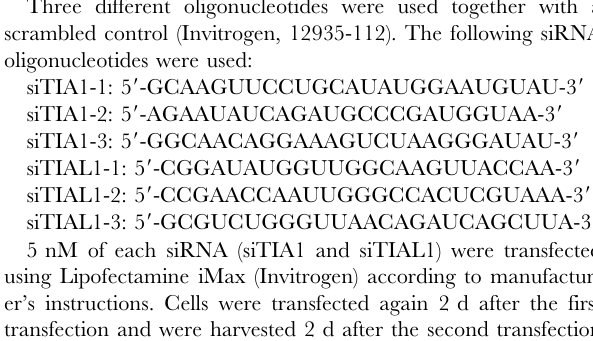
Figure S1 iCLIP and iCLAP of TIA1 and TIAL1. (A)